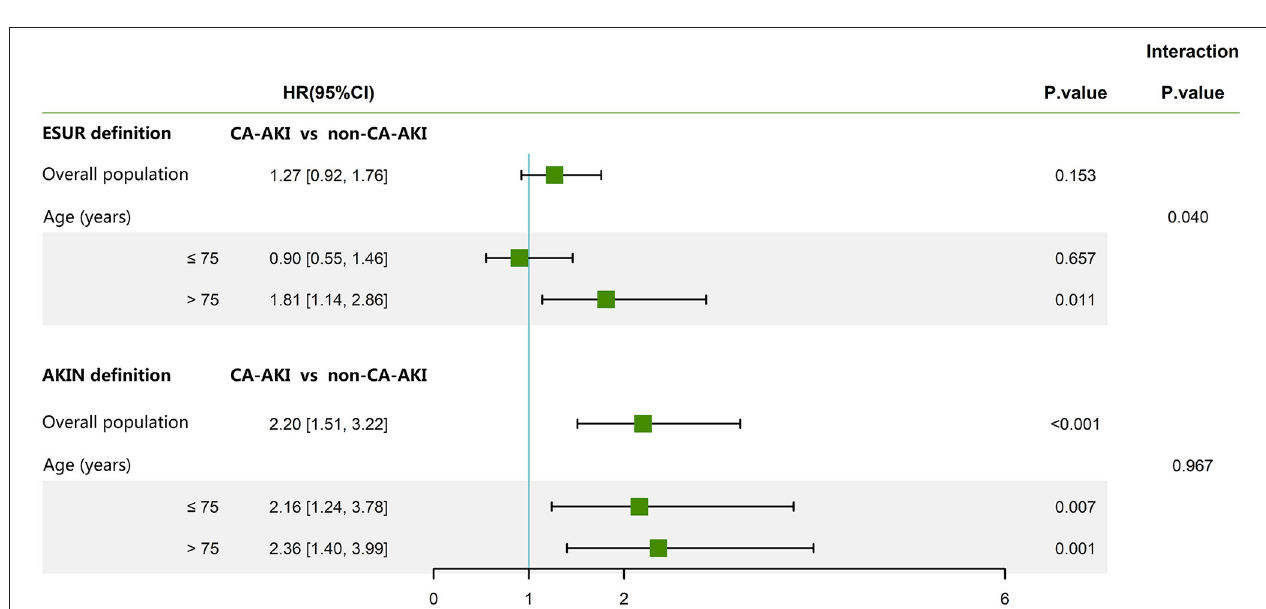
FIGURE 3 | The association between the two classical definitions of CA-AKI and long-term mortality. The following parameters were adjusted: age > 75 years, SCr > 1.5 mg/dl, hemoglobin, multivessel disease, acute myocardial infarction, diabetes, and previous myocardial infarction. CA-AKI, contrast-associated acute kidney injury; SCr, serum creatinine; AKIN, Acute Kidney Injury Network; ESUR, European Society of Urogenital Radiology; HR, hazard ratio; CI, confidence interval.